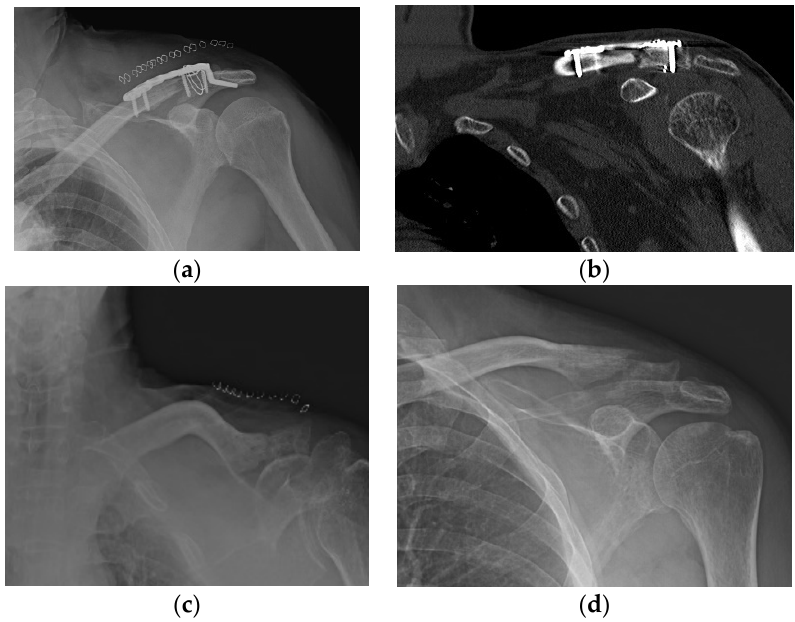
Figure 6. The only case of non-union among five incomplete union cases. ( a – c ) A 50-year-old male patient is fixed with a hook plate and bone union is not completed at 4 months, but severe painful shoulder stiffness is noted; therefore, manipulation is performed while removing the metal plate. ( d ) Bone union does not occur during the follow-up period.